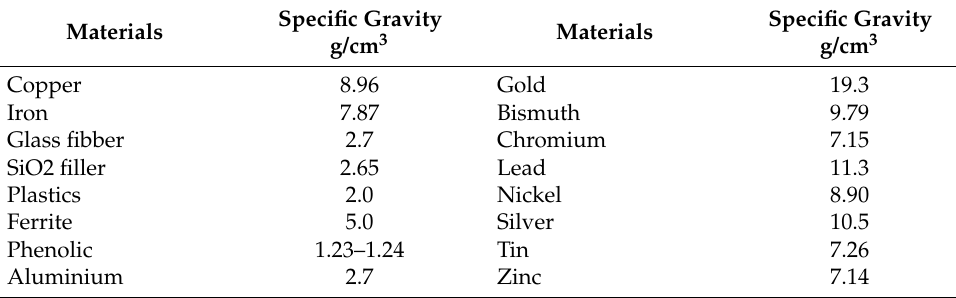
Table 2. Specific gravities of materials contained in printed circuit